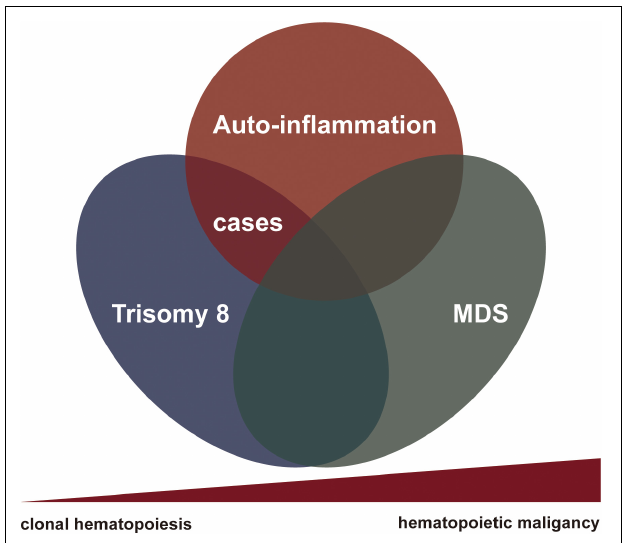
FIGURE 3 | The nexus between rheumatological conditions and clonal hematopoiesis toward to myelodysplasia.